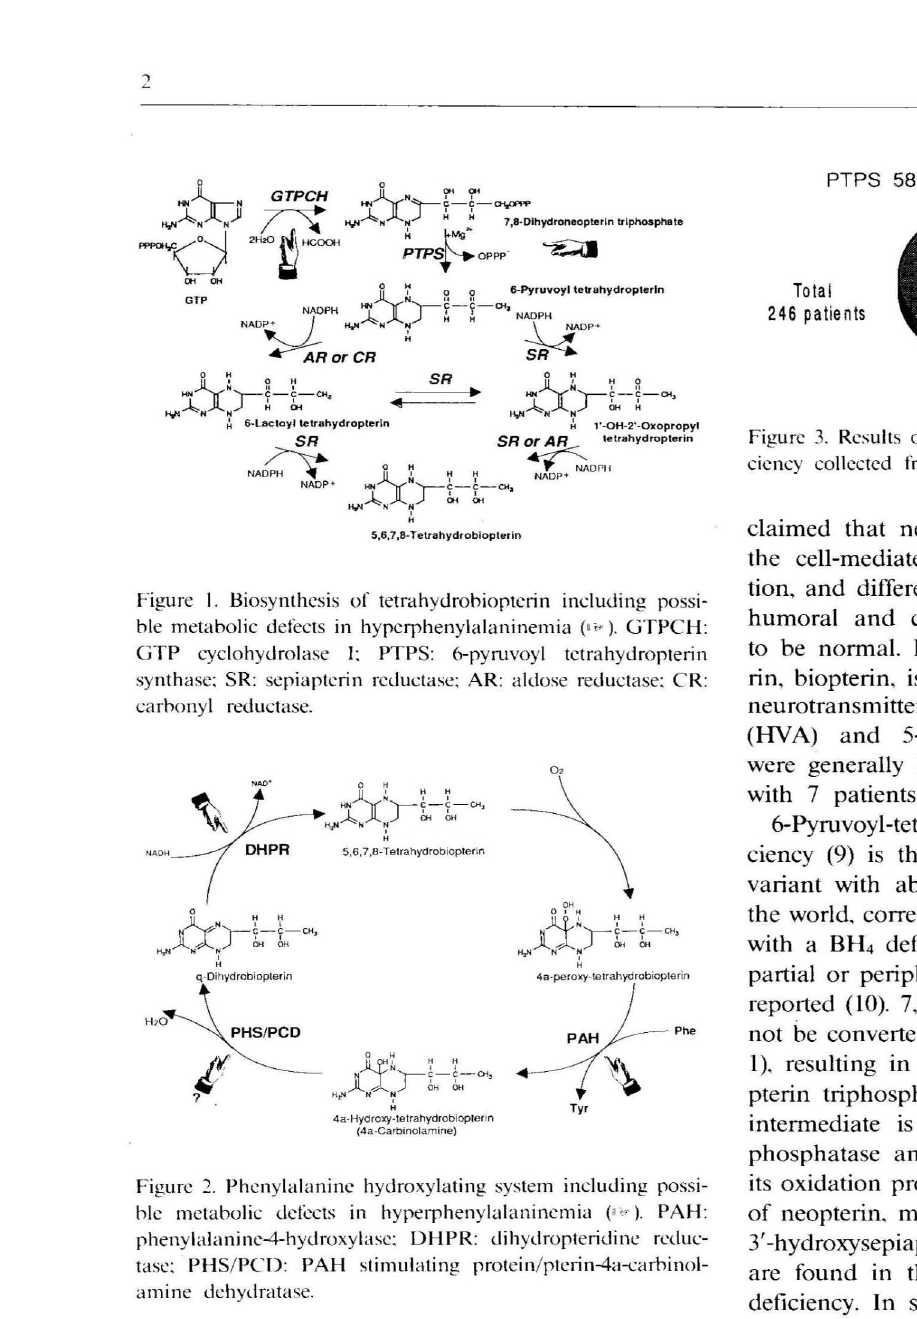
Figure 2. Phenylalanine hydroxylating system including possi hie metabolic defects in hyperphenylalaninemia (Ii' ). PAH: phenylalanine-4-hydroxylase: DHPR: dihydropteridine reduc tase: PHS/PCD: PAH stimulating protein/pterin-4a-carhinol amine dehydratase.